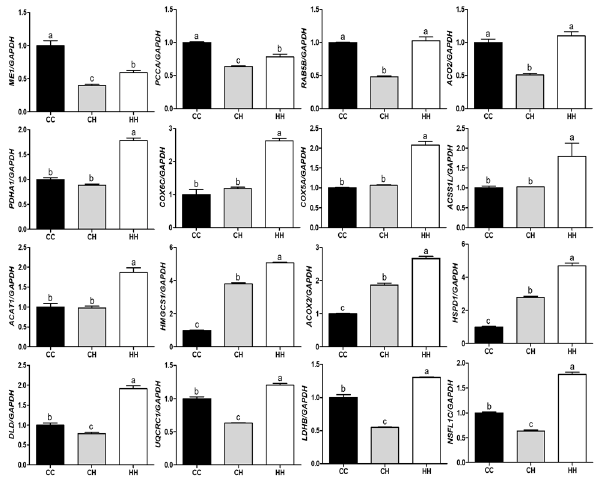
Figure 5. Effect of acute or early heat exposure on gene expression of differentially expressed proteins; a–c: different letters indicate significant differences ( p < 0.05). CC: control group. CH: acute heat stress group. HH: early and acute heat exposure group. The description of each gene is presented in Table S4.